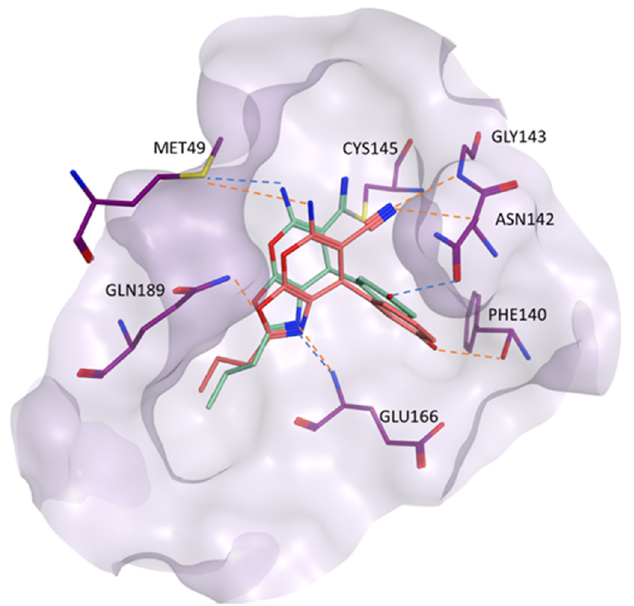
Figure 8. GR20 orientation in M pro ’s active site with noncovalent docking (pink) and covalent docking (green).